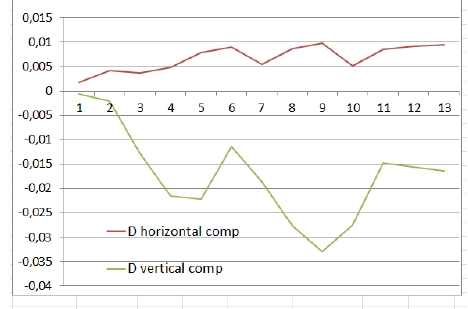
Figure 15. Coordinates differences [m] – mass market receiver and patch